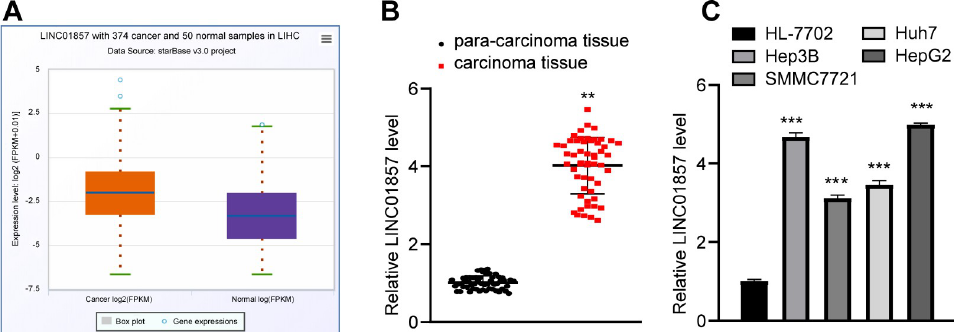
Fig 1. LINC01857 is overexpressed in HCC. A, LINC01857 expression in HCC predicted by the Starbase database. B, LINC01857 expression in HCC and paracancerous tissues detected via RT-qPCR, n = 54. C, LINC01857 expression in HCC cells examined by RT-qPCR. Three independent repeated cell tests were performed. The results were presented as mean ± standard deviation. The paired t-test was applied to analyze the data in panel B. One-way ANOVA was employed to analyze the data in panel C. Tukey’s multiple comparisons test was employed for the post hoc test. �� p < 0.01, ��� p <